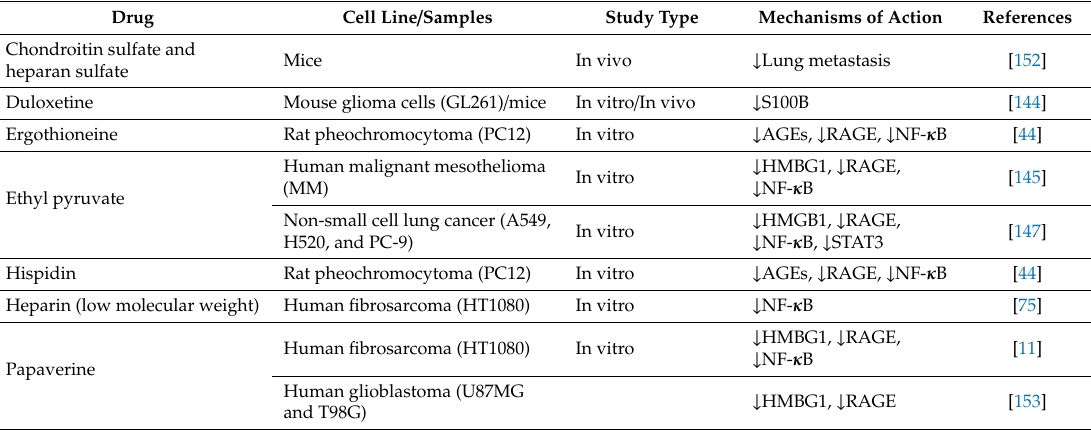
Table 4. Receptor for advanced glycation end product (RAGE)-inhibitors that attenuated cancer